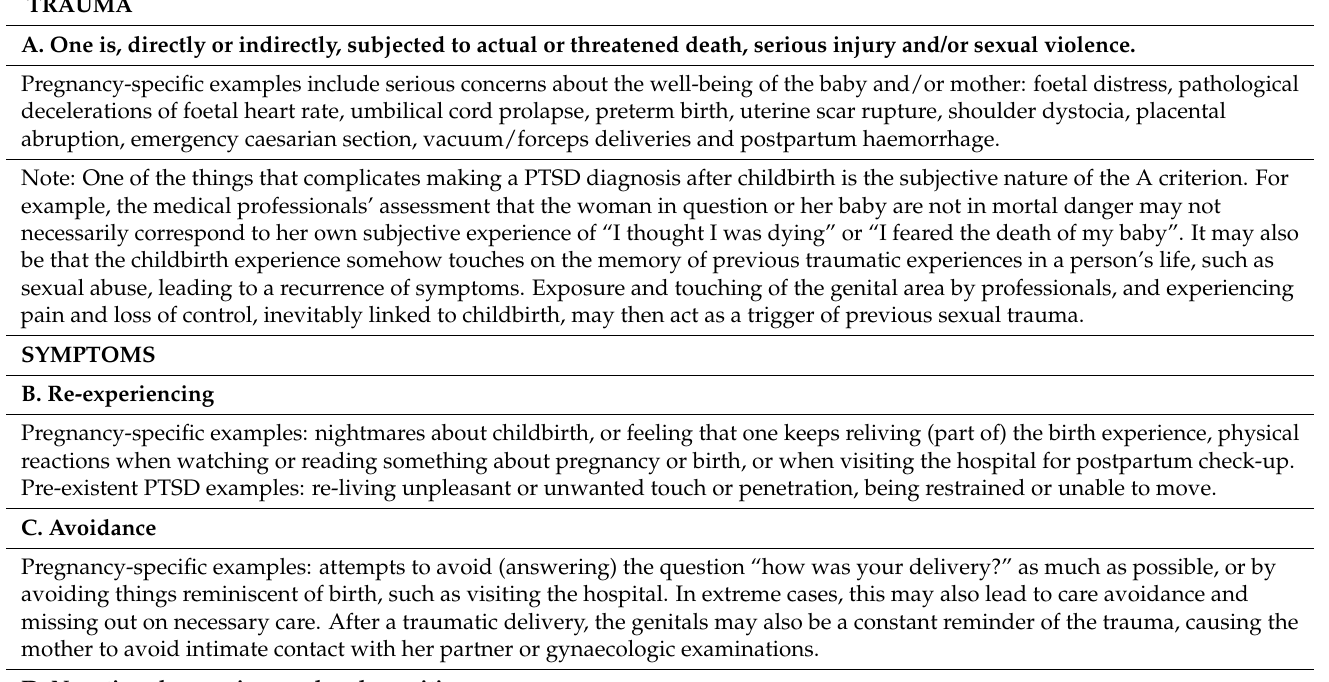
Table 1. PTSD criteria according to DSM-5, with examples from the pregnancy and childbirth domain.